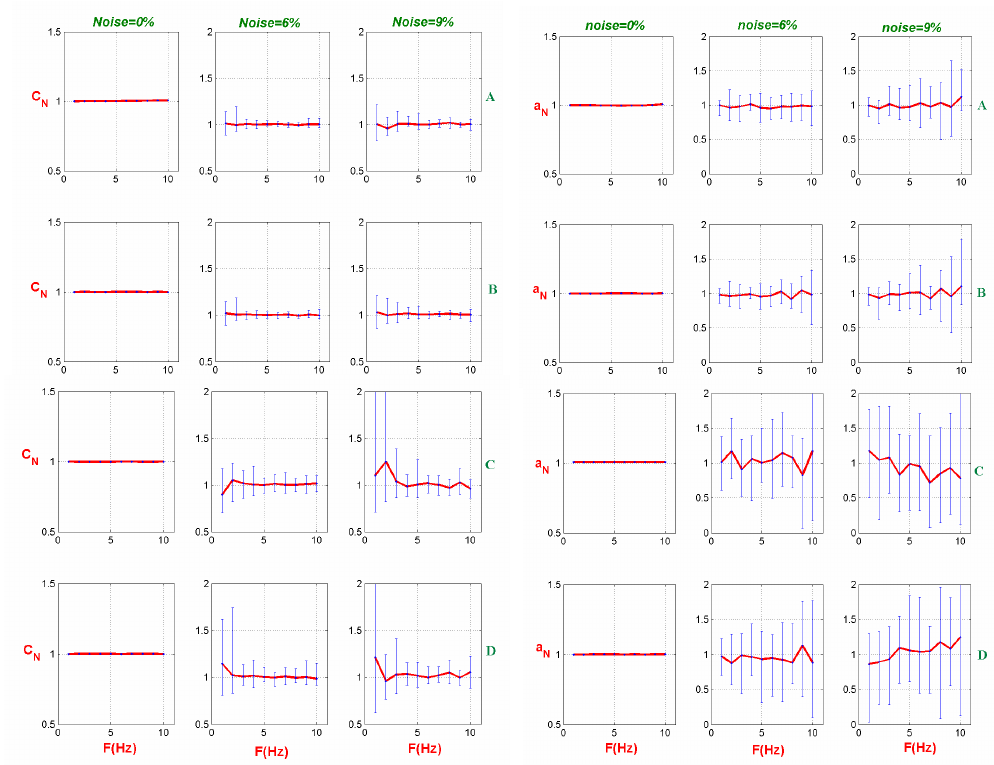
Fig.4 Frequency variation of normalized phase velocity for three amplitudes of noise (0%, 6% and 9%) obtained by the four methods: A (RV-I), B (RV-II), C (OCC) and D (3P). Data point are the mean and bars standard error of ten noise simulation.